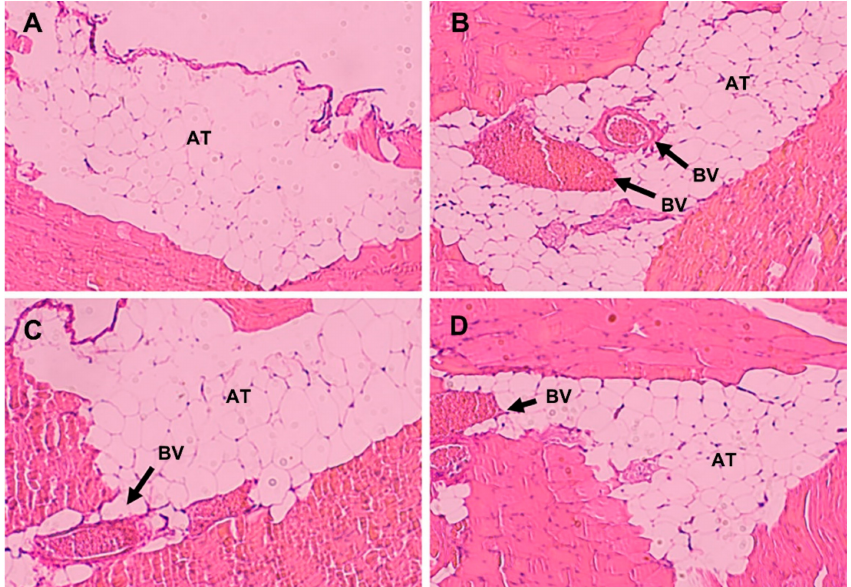
Figure 5. Representative HE-staining micrographs of peritoneal tissues in mice after intraperitoneal administration. Injection with saline ( A ), acetic acid ( B ), Diprivan ( C ), and propofol micelles ( D ). Arrows in the panels indicate AT = adipose tissue and BV = blood